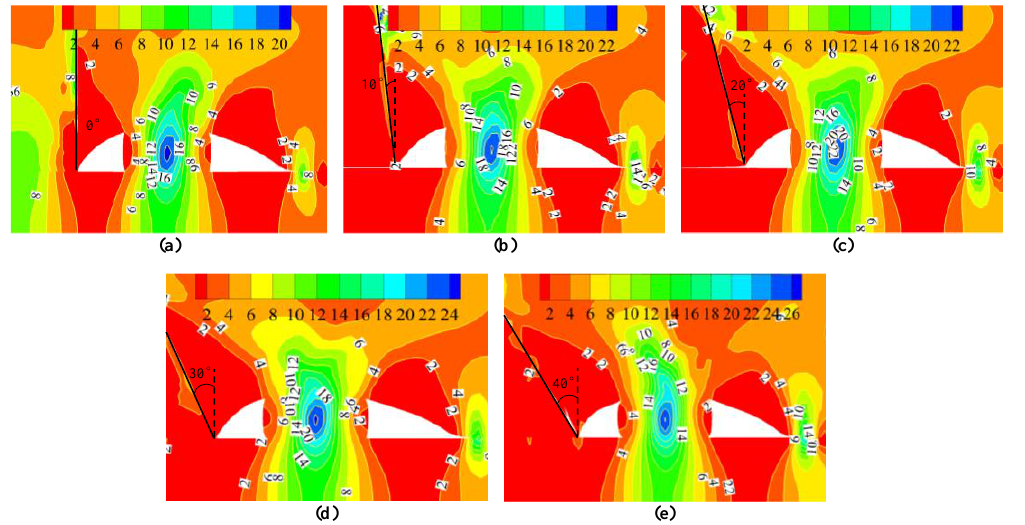
Figure 13. Nephogram of vertical stress distribution of surrounding rock with different top cutting angles: ( a ) 0°; ( b ) 10°; ( c ) 20°; ( d ) 30°; ( e ) 40°.